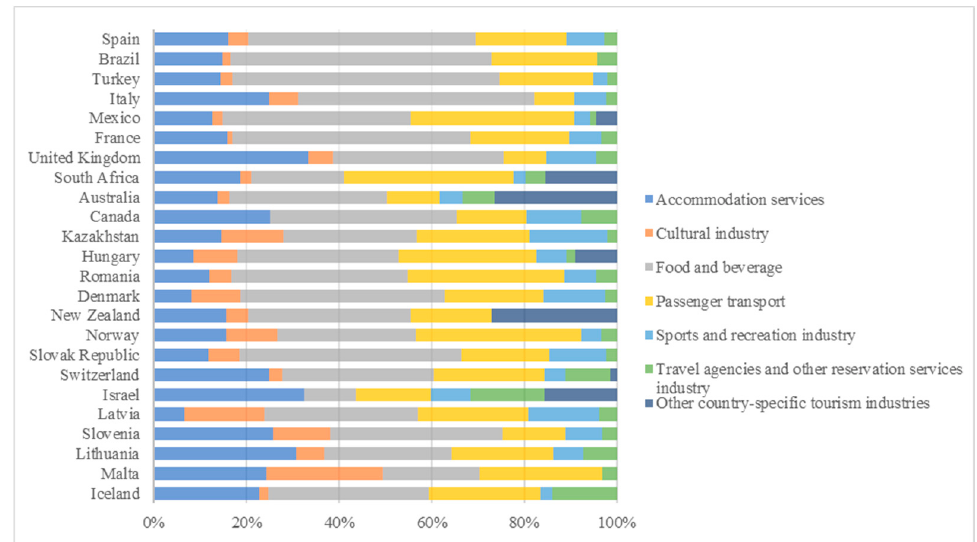
Figure 3. International tourism receipts per worker (USD) in 2017. Countries in alphabetical order. Source: UNWTO and OECD data for 2017.